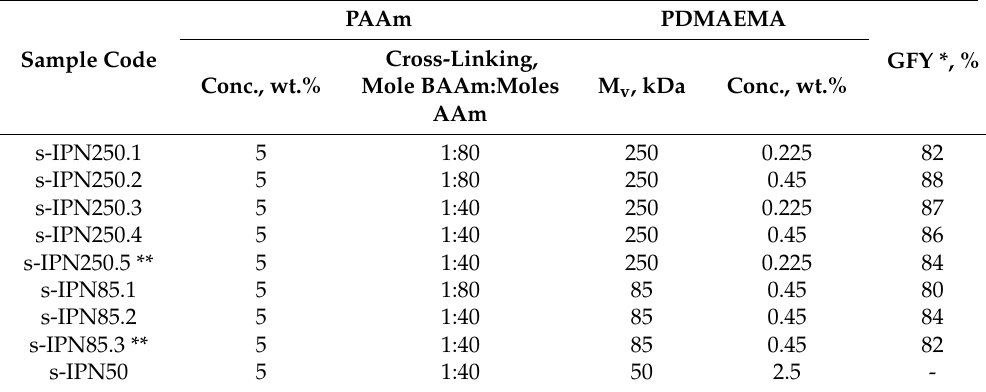
Table 2. Synthesis conditions of semi-IPN cryogels having PAAm as primary network and PDMAEMA as entrapped